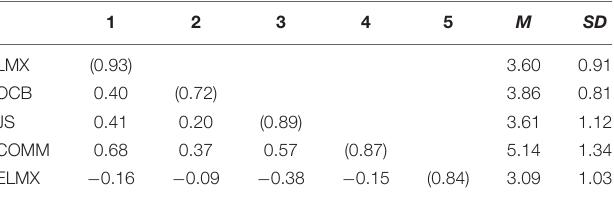
TABLE 4 | Correlations, alphas, means, and standard deviations (Study